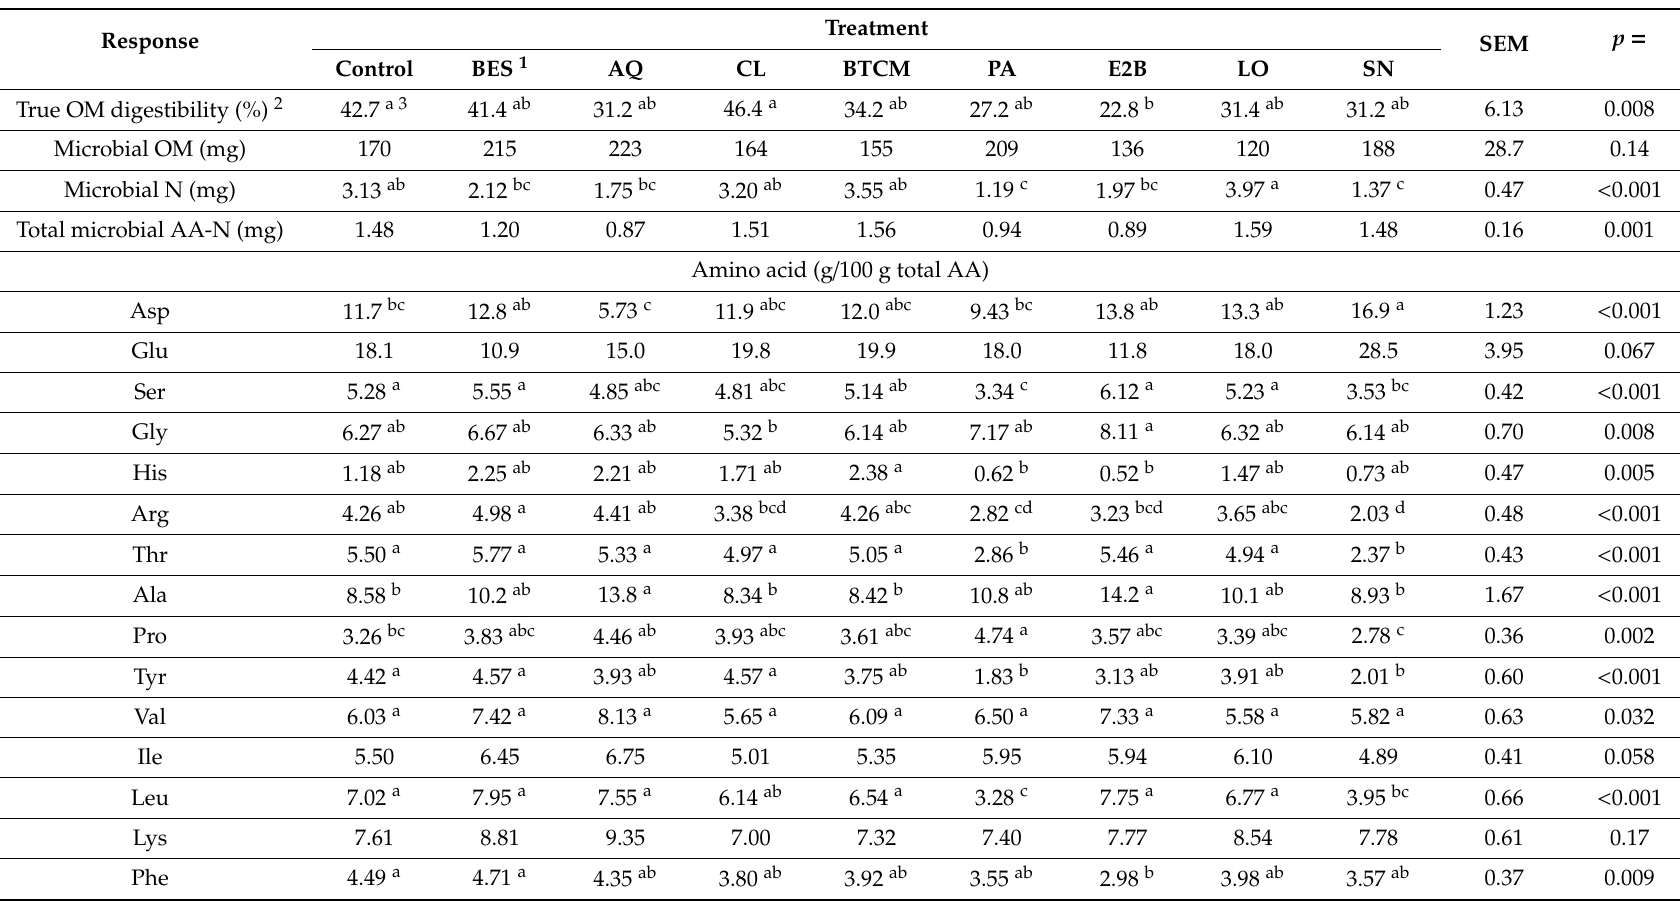
Table 2. E ff ects of several inhibitors of methanogenesis on digestion and microbial biomass production and composition of mixed rumen batch cultures.